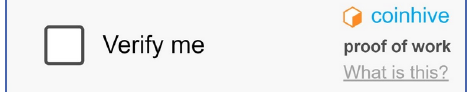
Figure 1. Coinhive